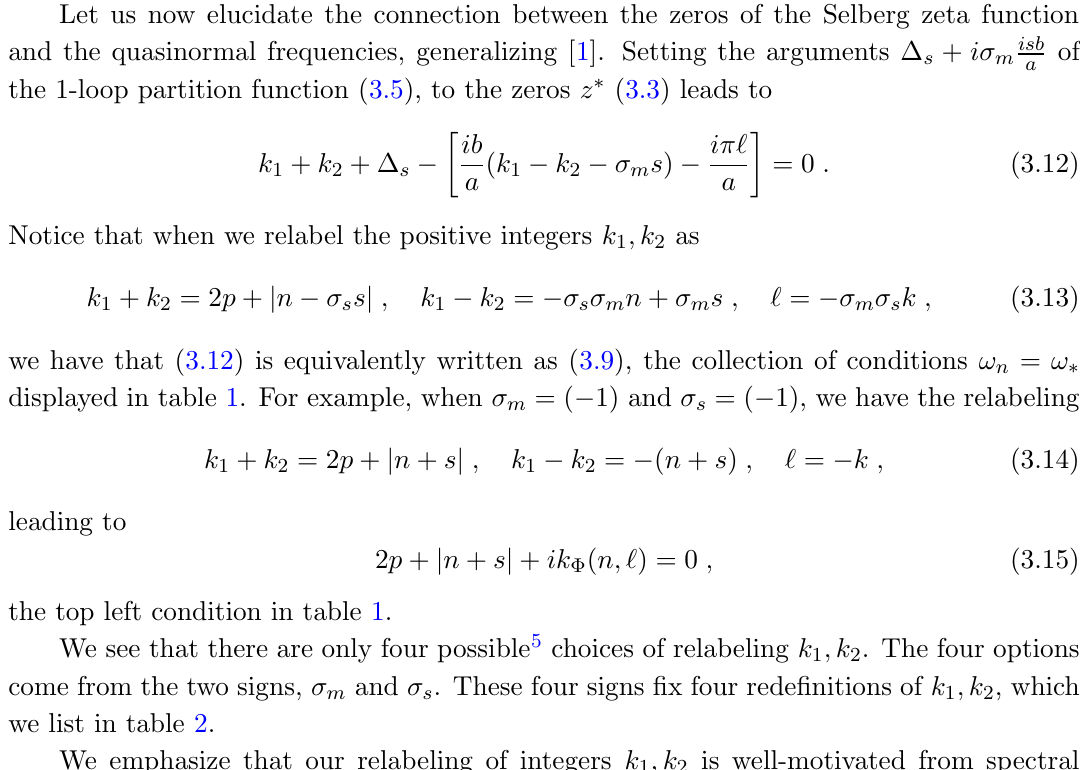
(cid:6) isb of the Selberg s a